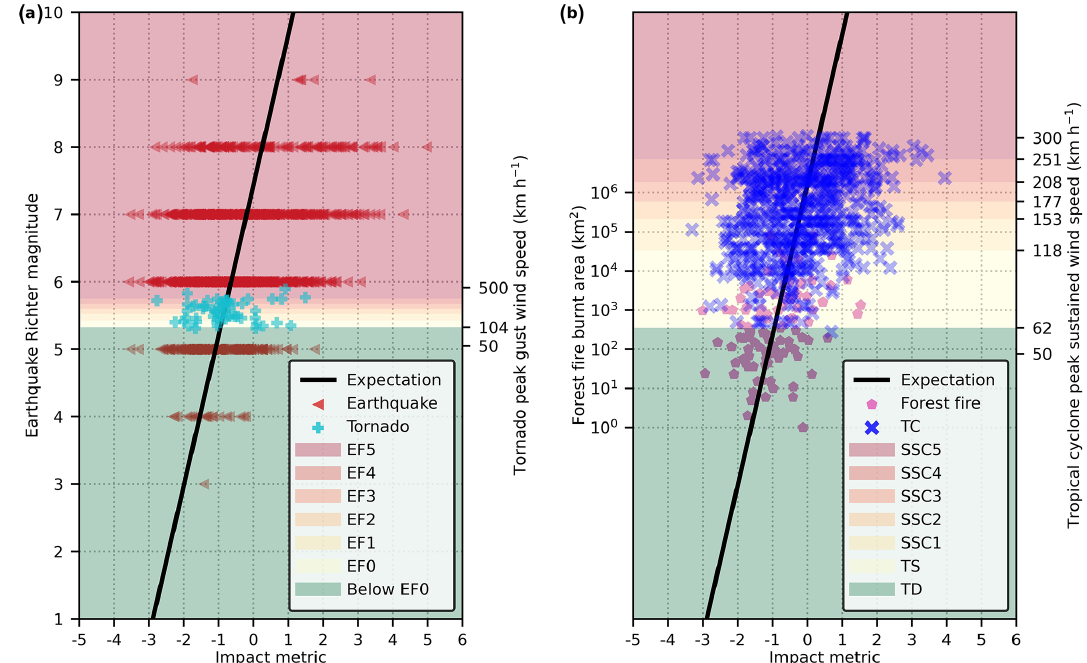
Figure 5. Comparisons of hazard magnitudes of four hazard types. (a) Earthquake Richter magnitude versus tornado enhanced Fujita scale. EF0, EF1, EF2, EF3, EF4, and EF5 are enhanced Fujita scale 0, 1, 2, 3, 4, and 5 with gust wind speed at 104–137, 138–177, 178–217, 218–266, 267–322, and over 322kmh − 1 , respectively. (b) Forest fire burnt area versus tropical cyclone Saffir–Simpson wind scale. TD and TS are tropical depression and tropical storm with sustained wind speed below 63kmh − 1 and at 63–118kmh − 1 , respectively; SSC1, SSC2, SSC3, SSC4, and SSC5 are Saffir–Simpson category 1, 2, 3, 4, and 5 with sustained wind speed at 119–153, 154–177, 178–208, 209–251, and over 251kmh − 1 , respectively; TC is tropical cyclone. Panels (a) and (b) are plotted with the same range and scale with respect to the earthquake Richter